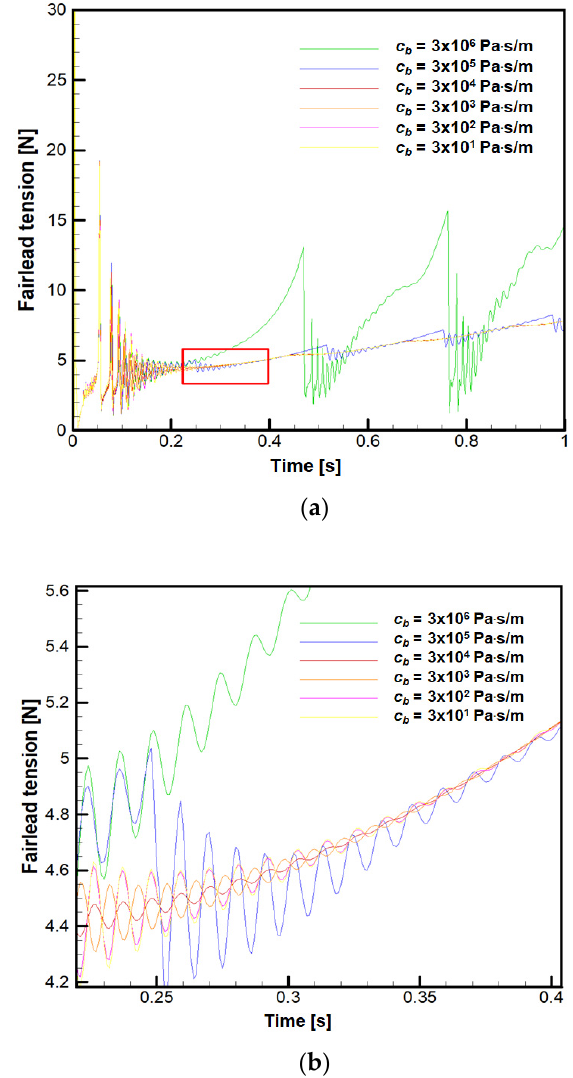
Figure 9. Fairlead tension for various seabed damping coefficients: ( a ) Global view for discontinuity of fairlead tension; ( b ) Local view for oscillation of fairlead tension.